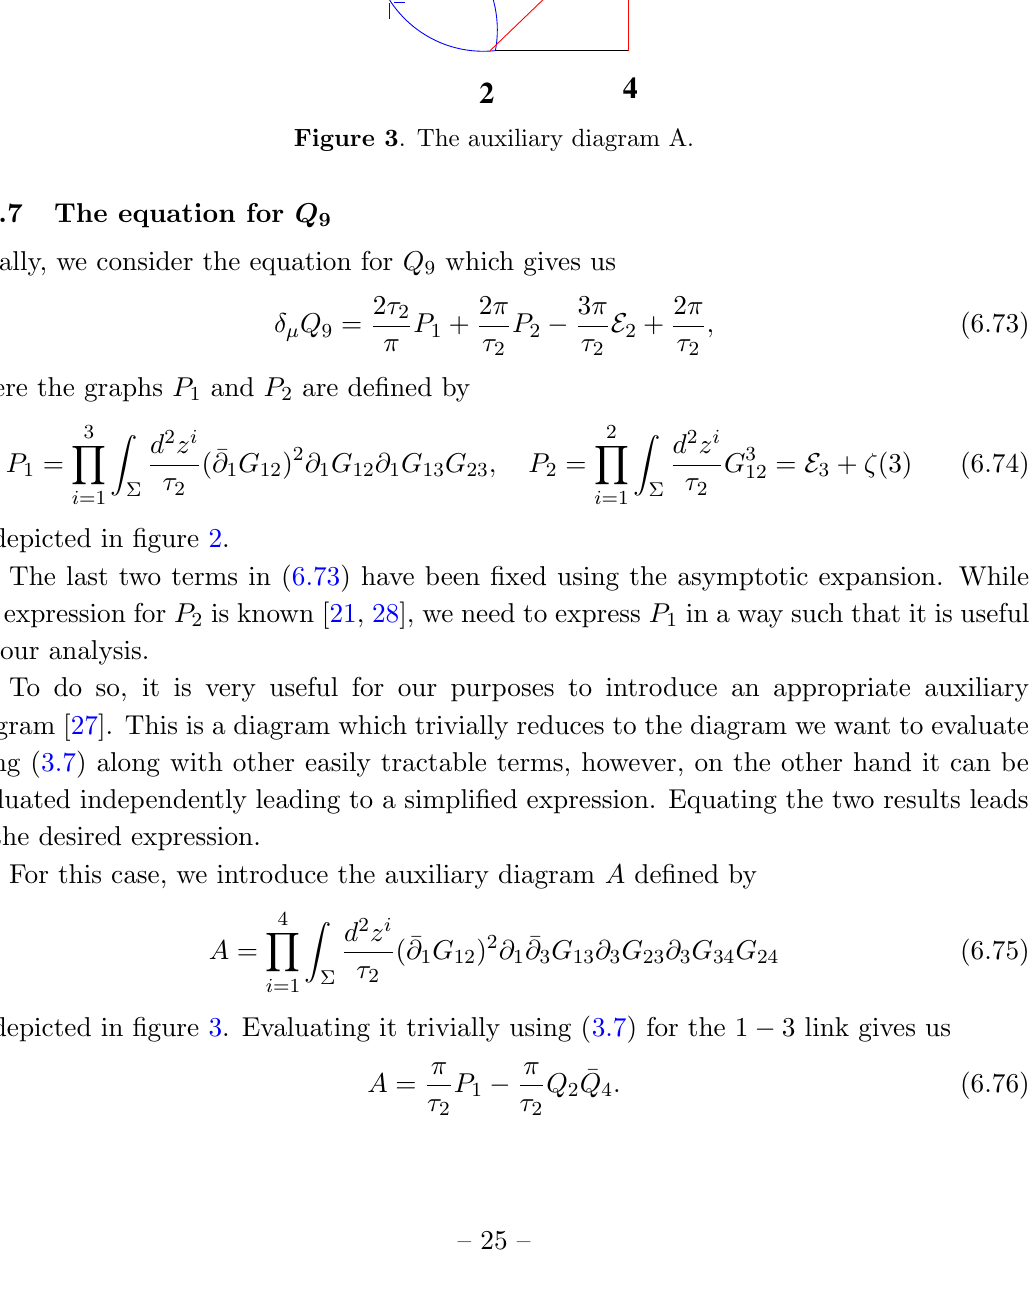
Figure 2 . (i) P 1 and (ii) P 2 .